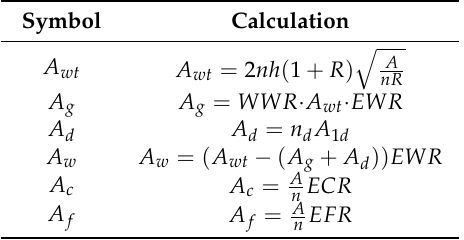
Table 1. Relationship between the house structure and